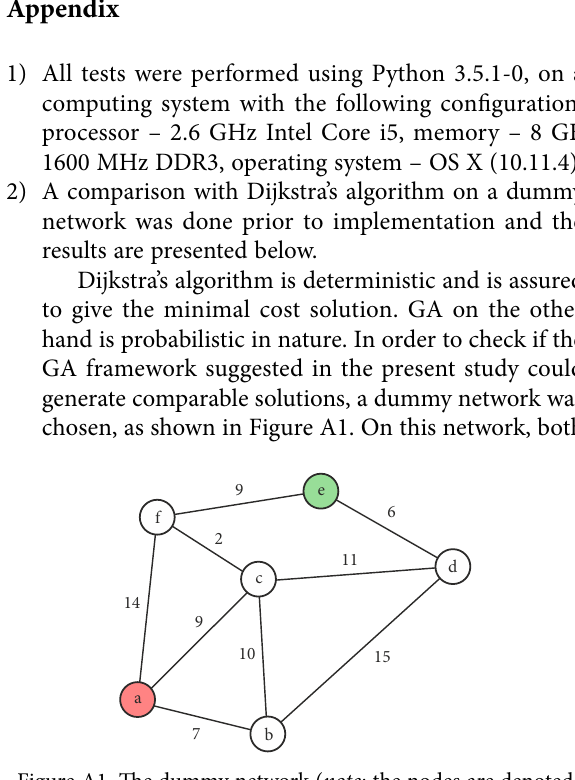
Figure A1. The dummy network ( note: the nodes are denoted by lower-case alphabets and the numbers on the links represent cost associated with